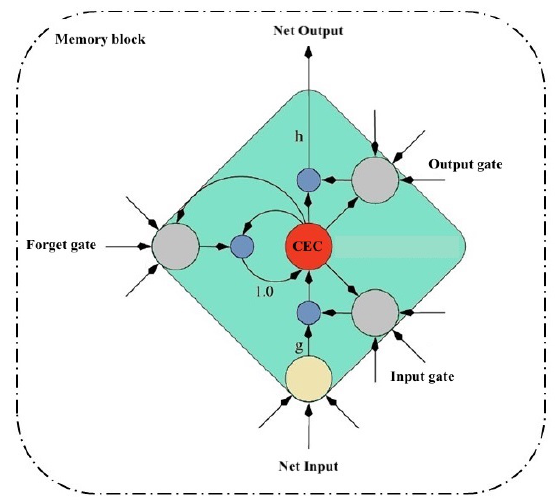
Figure 3. LSTM network memory block. The block has a recurrent connection with the weights set to 1.0. The three gateways collect input from the rest of the network and check the status of the memory block via three multiplicate units (marked in blue). The letters g and h depict the application of a nonlinear function